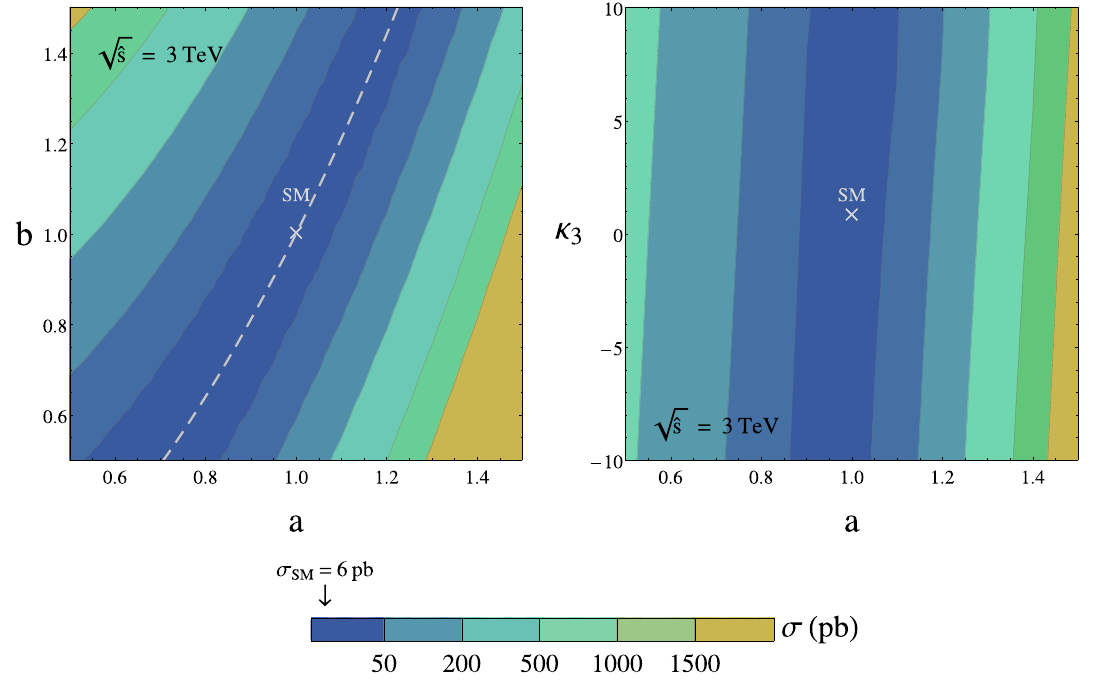
Fig. 11 EChL predictions for the total cross section of the W − W + → H H subprocess, at a center of mass energy of 3 TeV, in the ( a , b ) plane (leftpanel)andthe ( a ,κ 3 ) plane(rightpanel).Thedashedlineintheleft